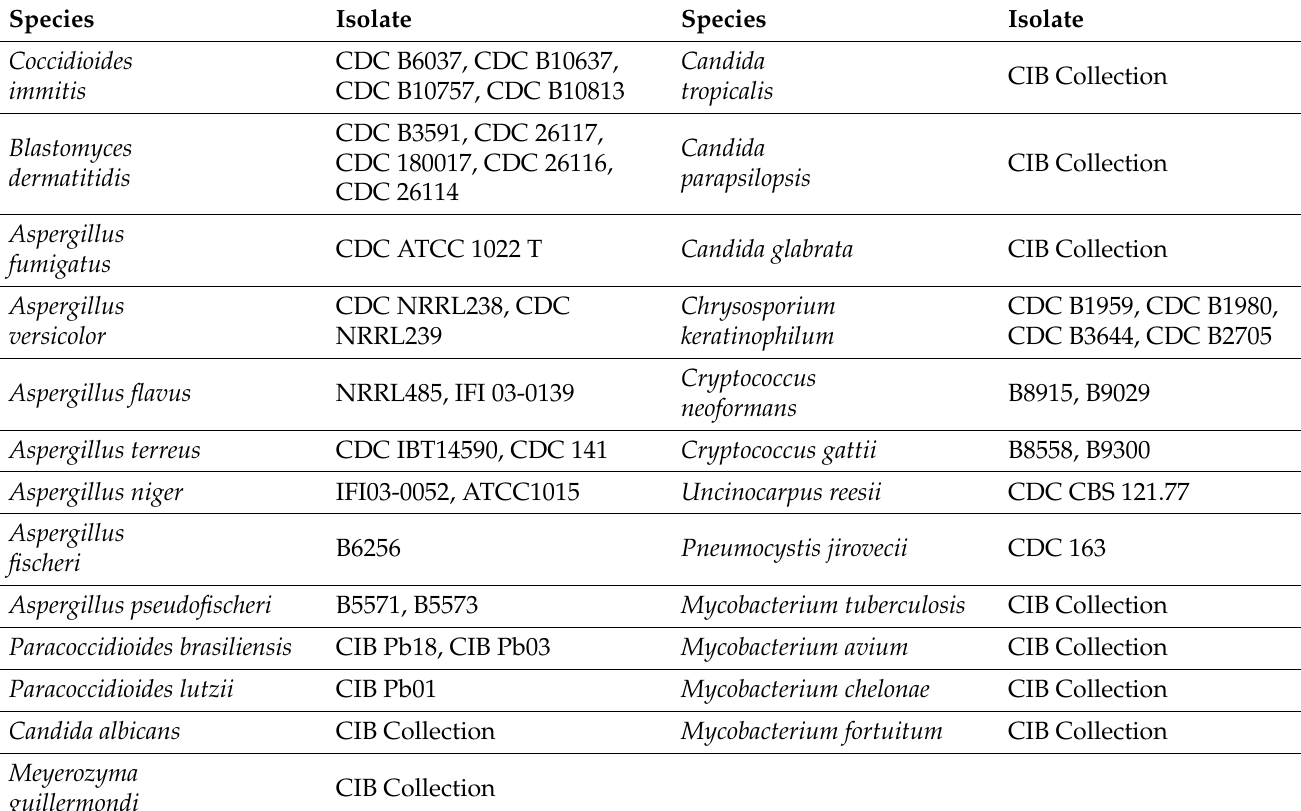
Table 1. Non- Histoplasma species used for in vitro testing of analytical specificity. Species